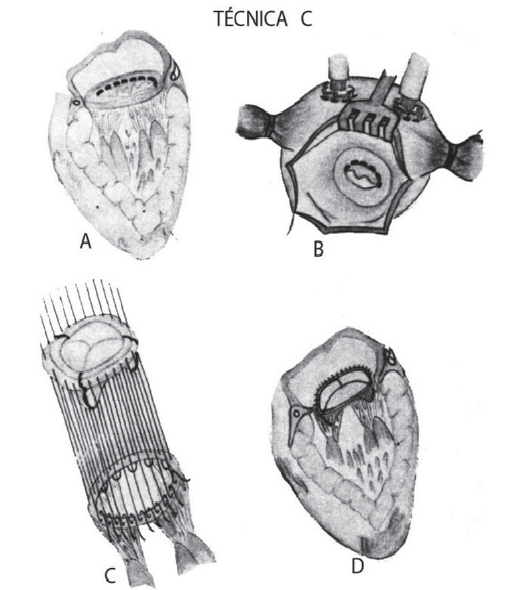
Fig. 3 - Prótese mitral com preservação dos elementos do sistema subvalvar: excisão parcial apenas da cúspide anterior com fixação de seus músculos papilares de cordas tendíneas (Évora et al., Rev Bras Cir Cardiovasc. 1988;3(1):36-49)